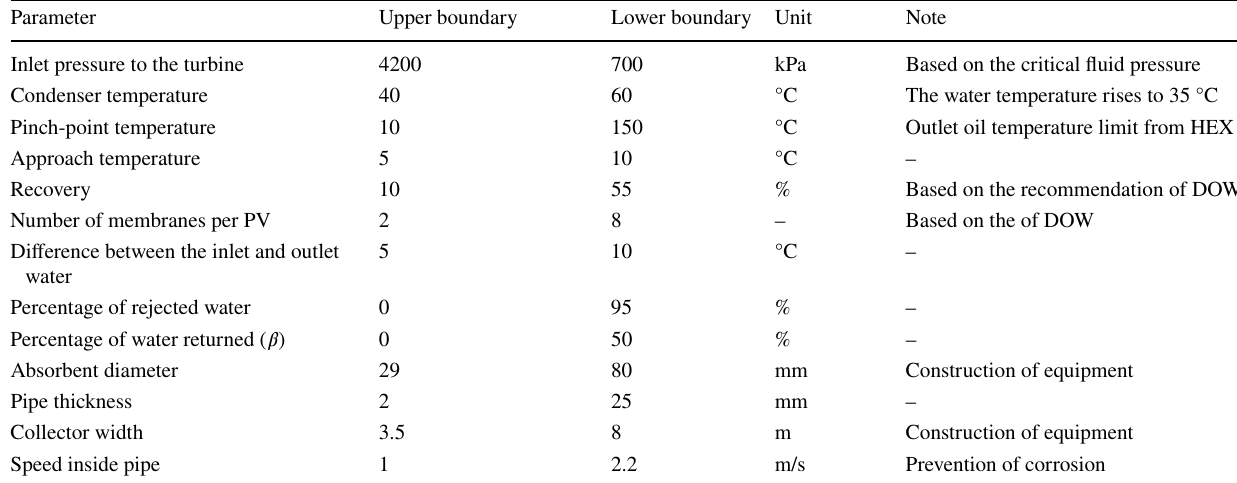
Table 7 Optimization results based on the best optimal point Parameter